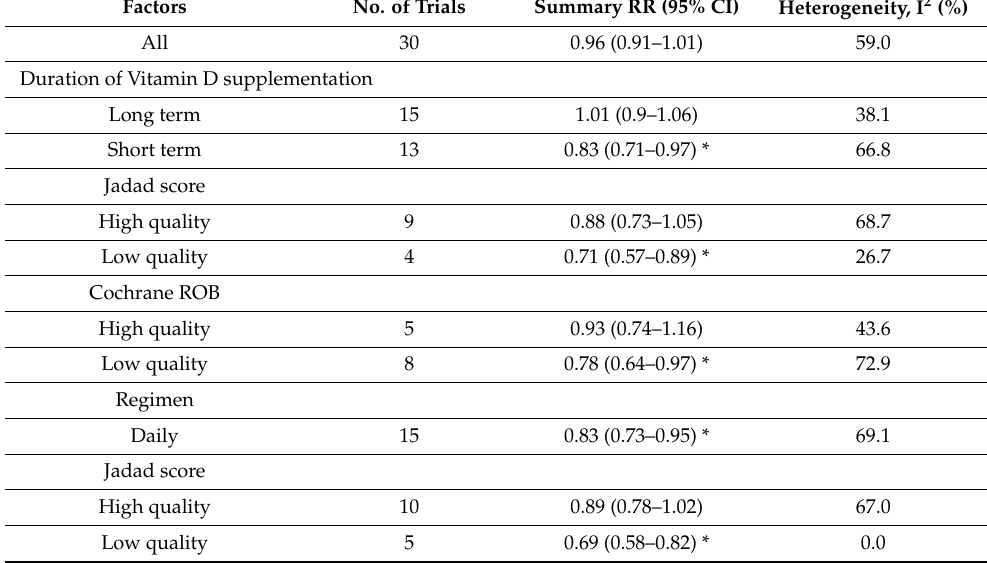
Table 4. Vitamin D supplementation in prevention of acute respiratory infections in the subgroup meta-analysis of randomized controlled trials by various